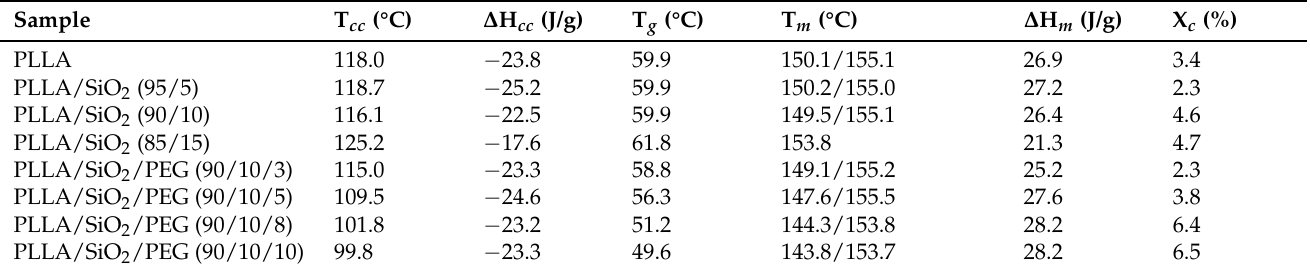
Table 5. Enthalpy of fusion, glass transition, melting temperature, and degree of crystallinity from the second heating step at 10 °C/min.